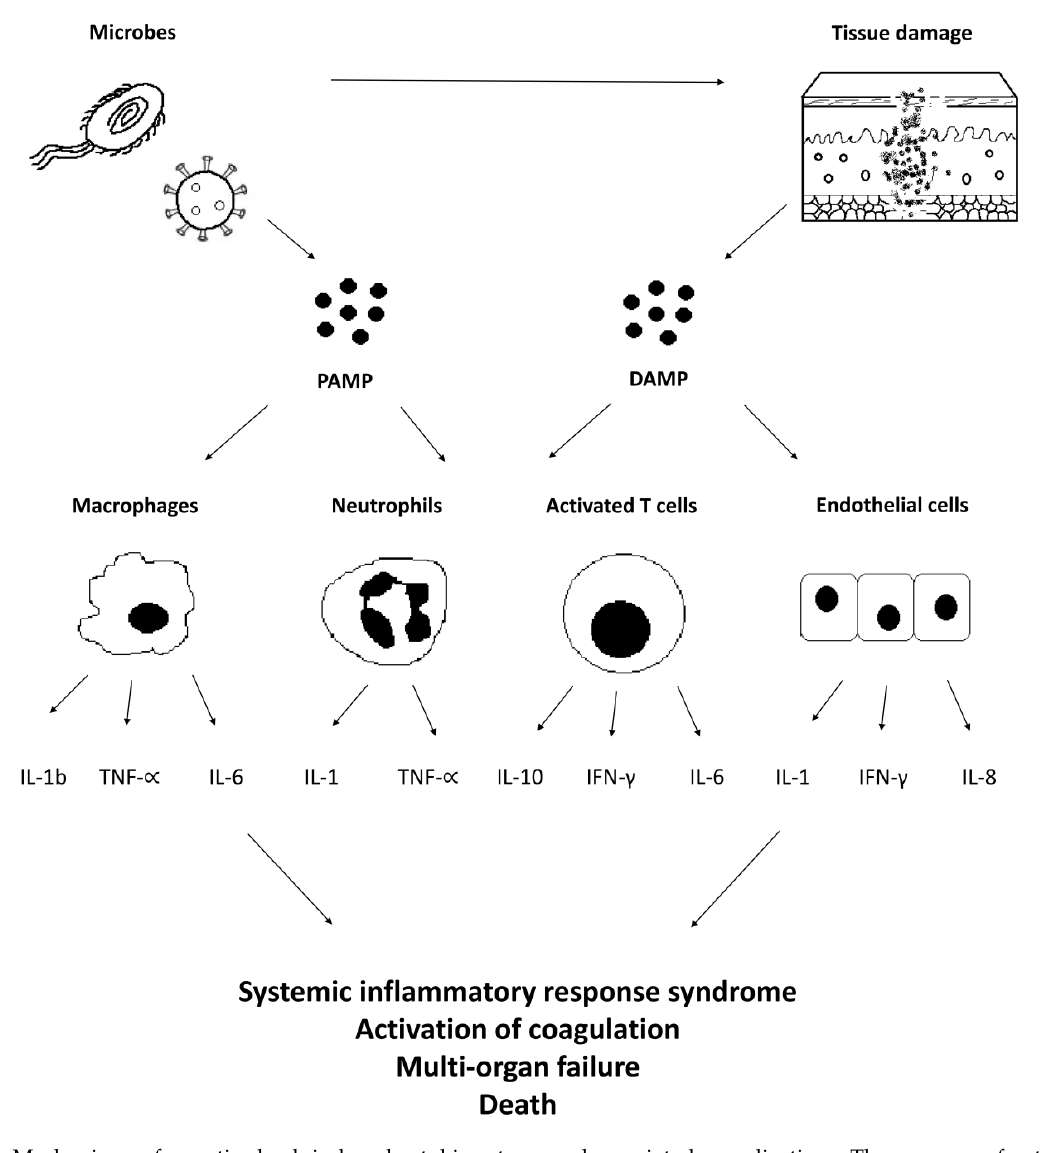
Figure 1. Mechanisms of a septic-shock-induced cytokine storm and associated complications. The presence of pathogenic microbes leads to the detection of pathogen-associated molecular patterns (PAMPs) and damage-associated molecular patterns (DAMPs) that both lead to dysregulated activation of various cells (especially macrophages, T-cells, neutrophils, and endothelial cells). This is followed by the release of proinflammatory and anti-inflammatory cytokines. The dysregulated host response can induce many clinical adverse effects, including systemic inflammatory response syndrome, multi-organ failure, activation of coagulation, or death. PAMP, pathogen-associated molecular pattern; DAMP, damage-associated molecular pattern; IL, interleukin; IFN, interferon; and TNF, tumor necrosis